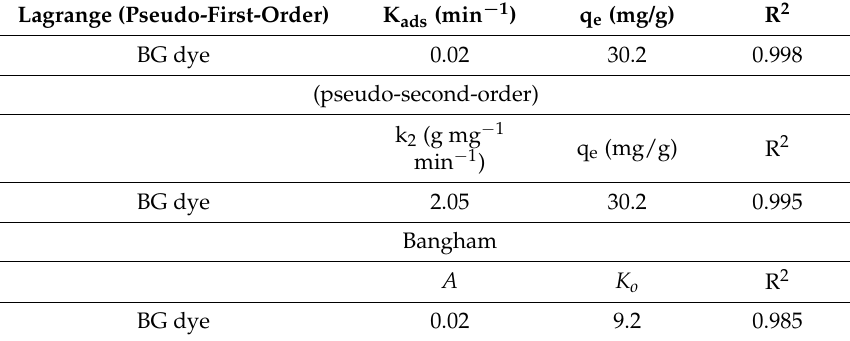
Table 1. Kinetics parameters for the sorption of BG dye on Hap/CS nanocomposite. Lagrange